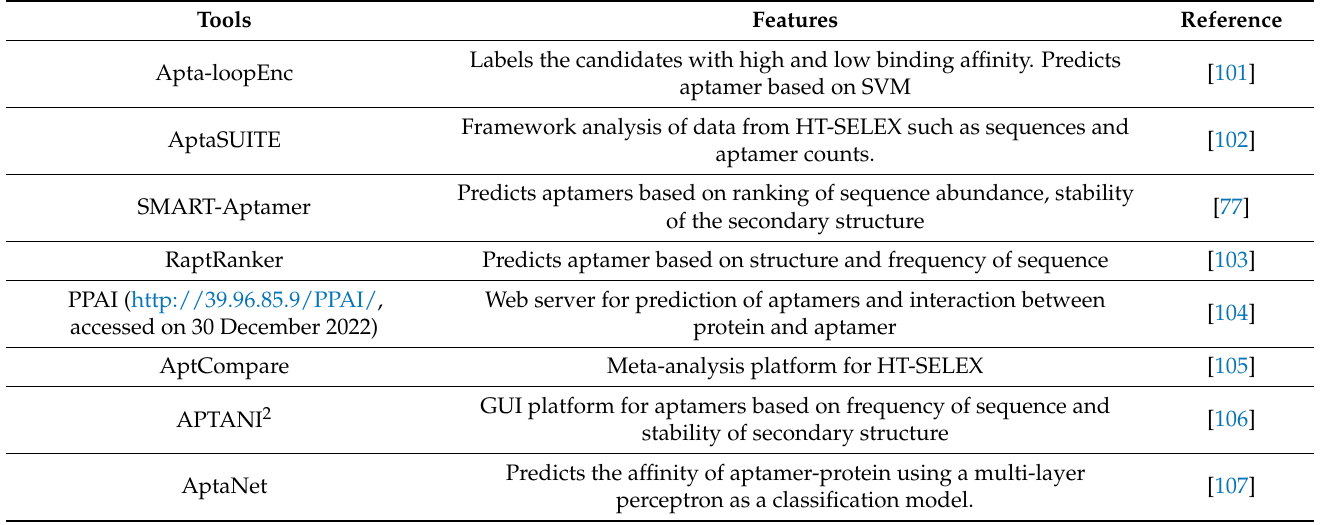
Table 2. In silico tools for designing